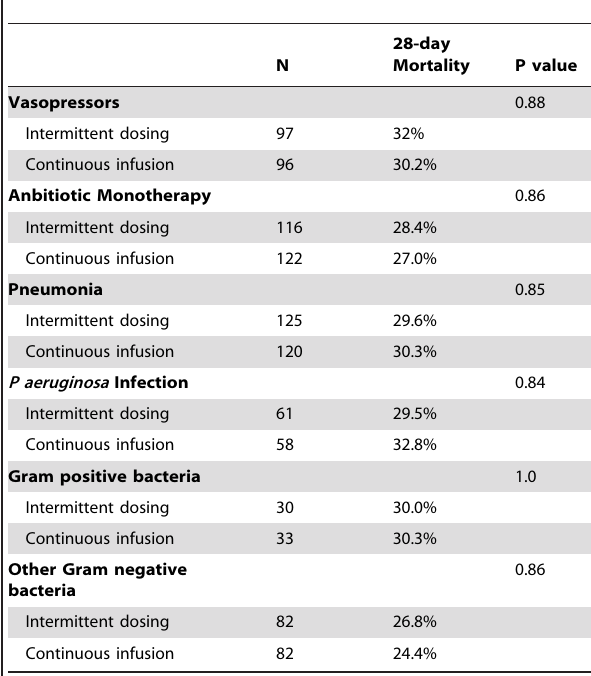
Table 4. Sub-group analyses of 28-day